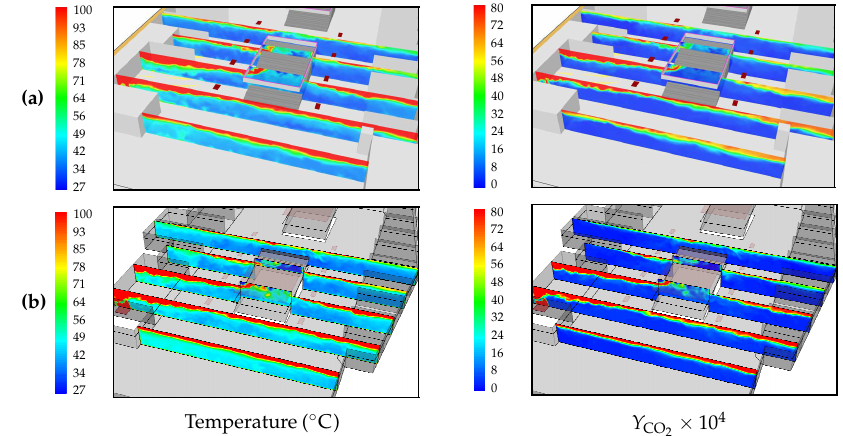
2 × 10 4 ) (right column)